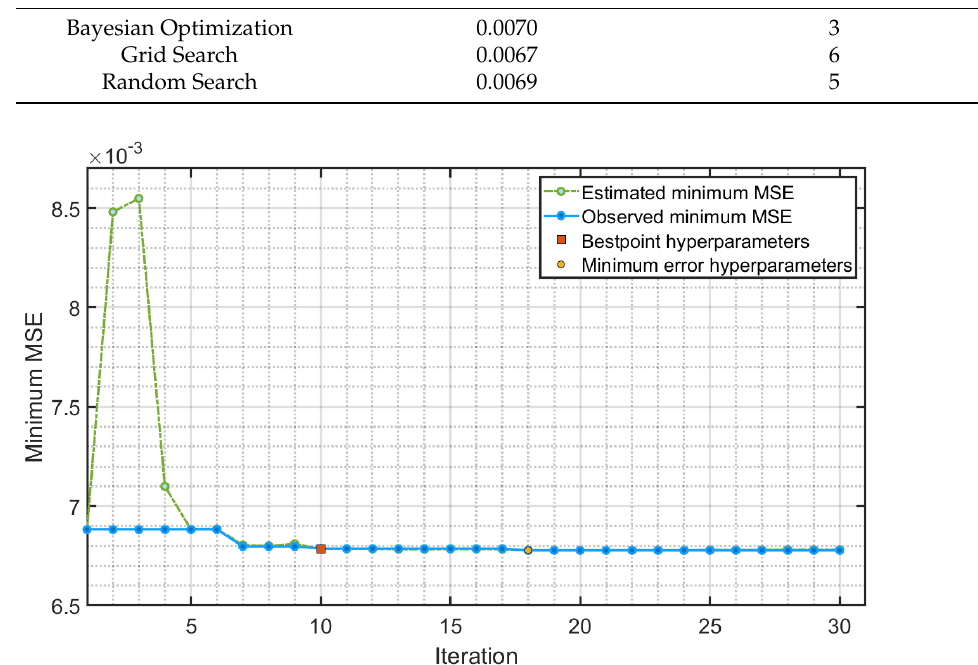
Figure 15. Tuned hyperparameters Graphs of Tree using Grid